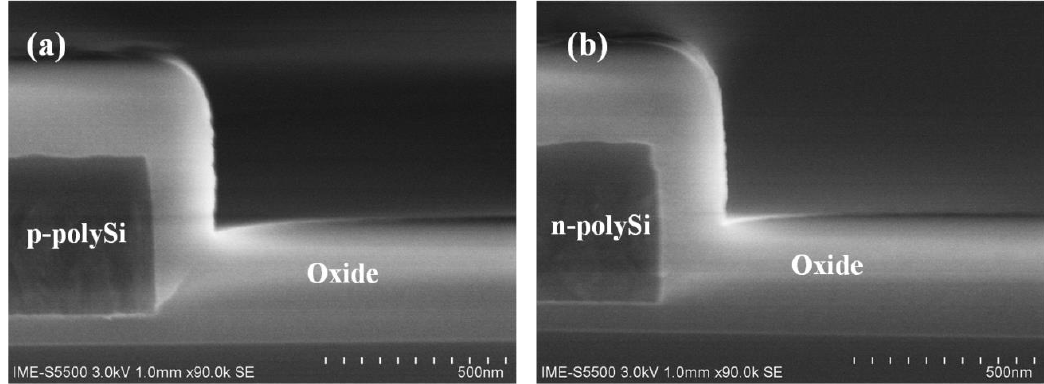
Figure 8. ( a ) p- type polysilicon and ( b ) n-type polysilicon covered with oxide film after